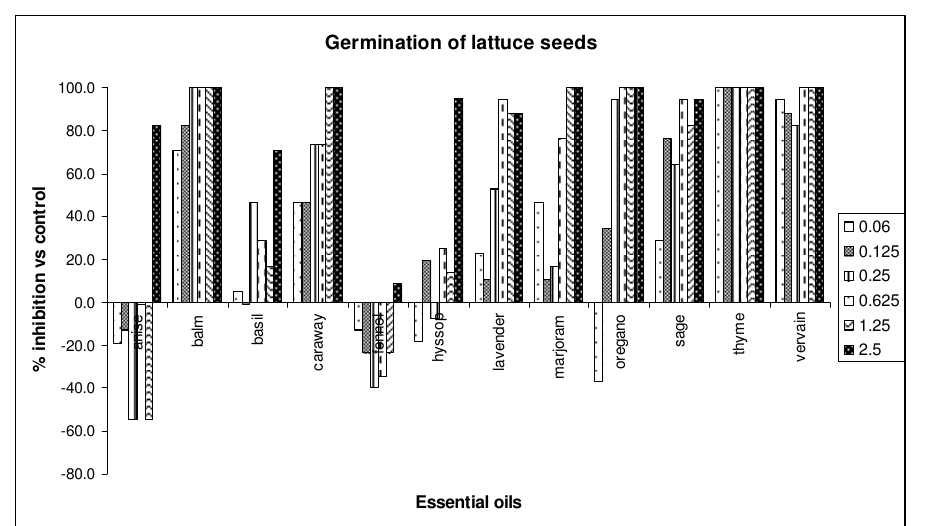
Figure 3. Percent inhibition of germination of Lactuca sativa seeds treated with different doses of essential